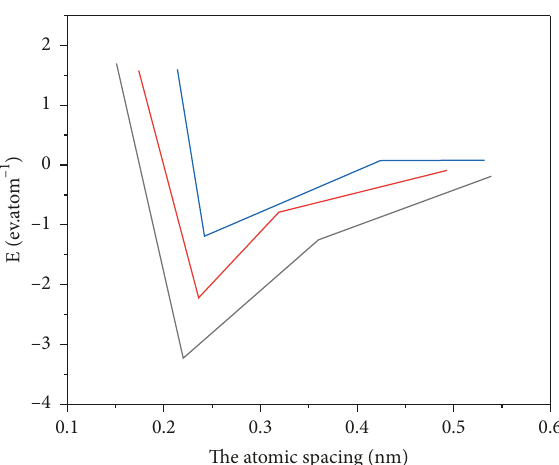
Figure 3: Potential energy curve of Ag.